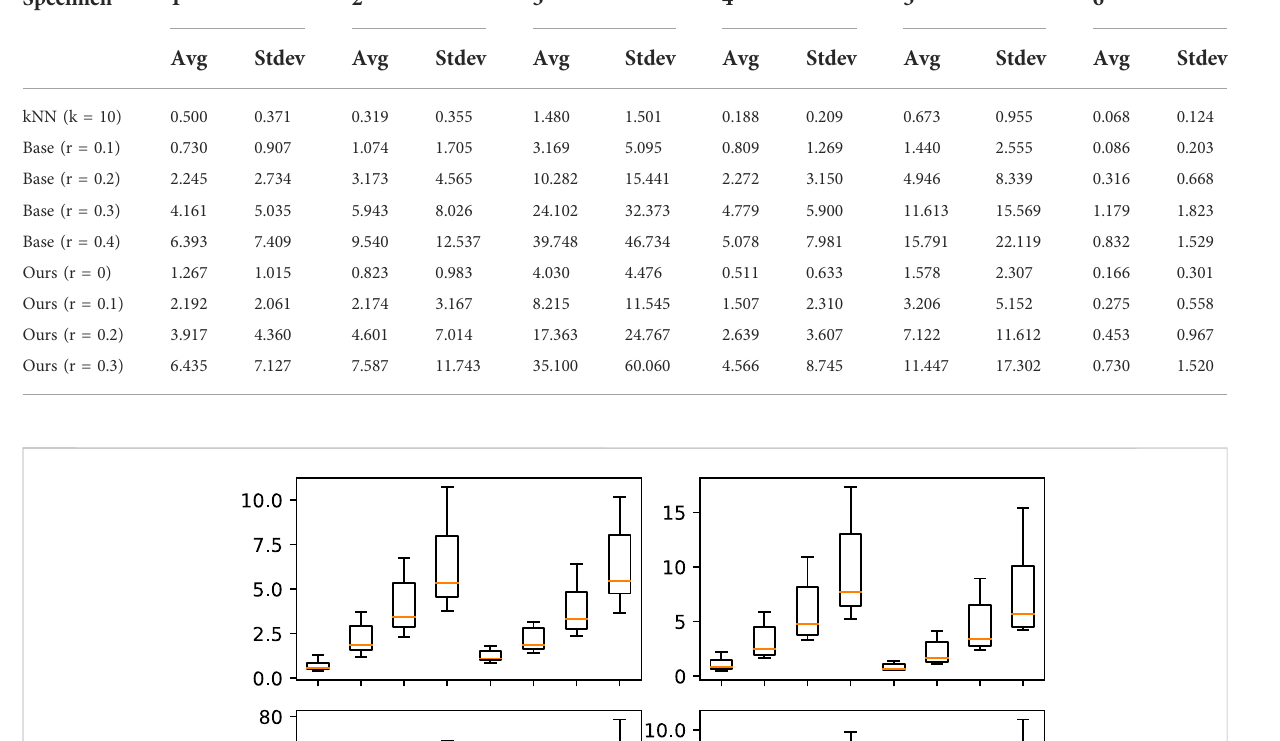
TABLE 3Performanceof the proposed methodfor six different specimensoftrees. The meanand standard deviationareobtainedby consideringten samples of each specimen.